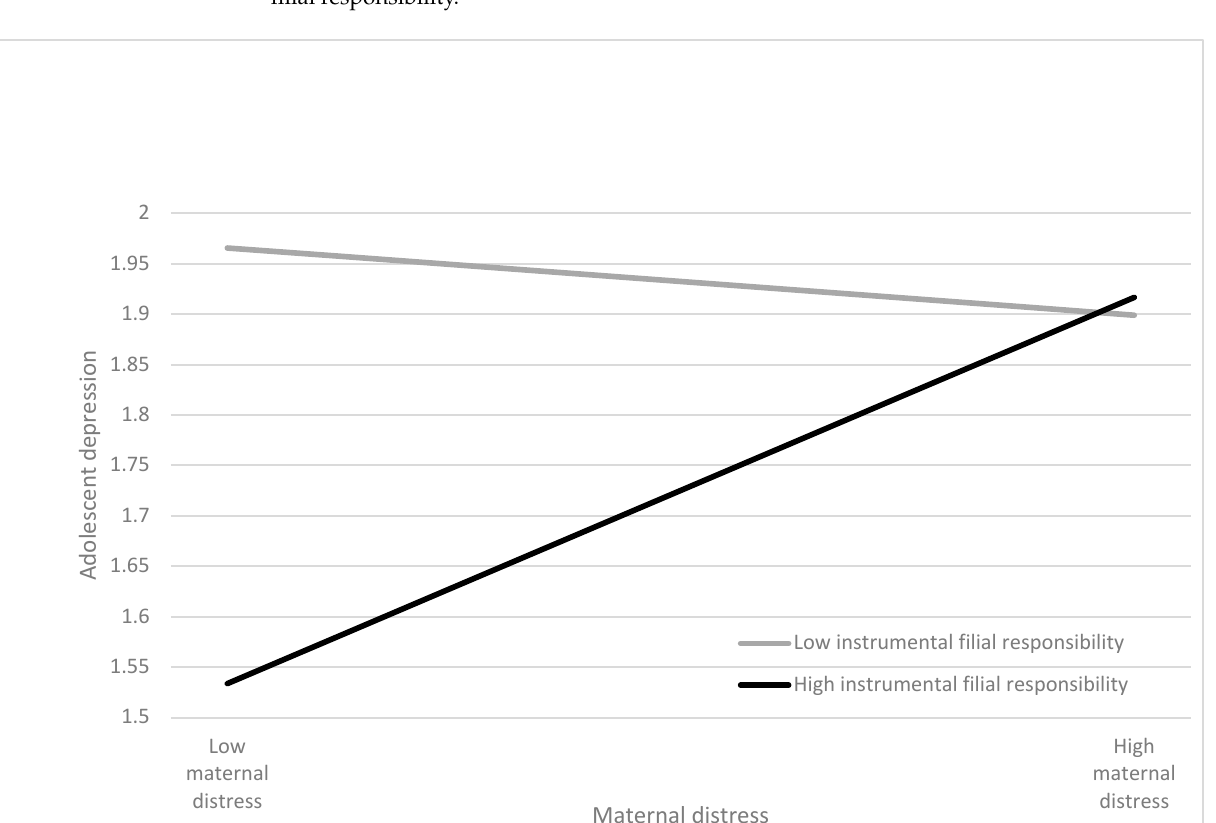
Figure 2. Regression of adolescent depression by maternal distress in high and low levels of instru- mental filial responsibility.